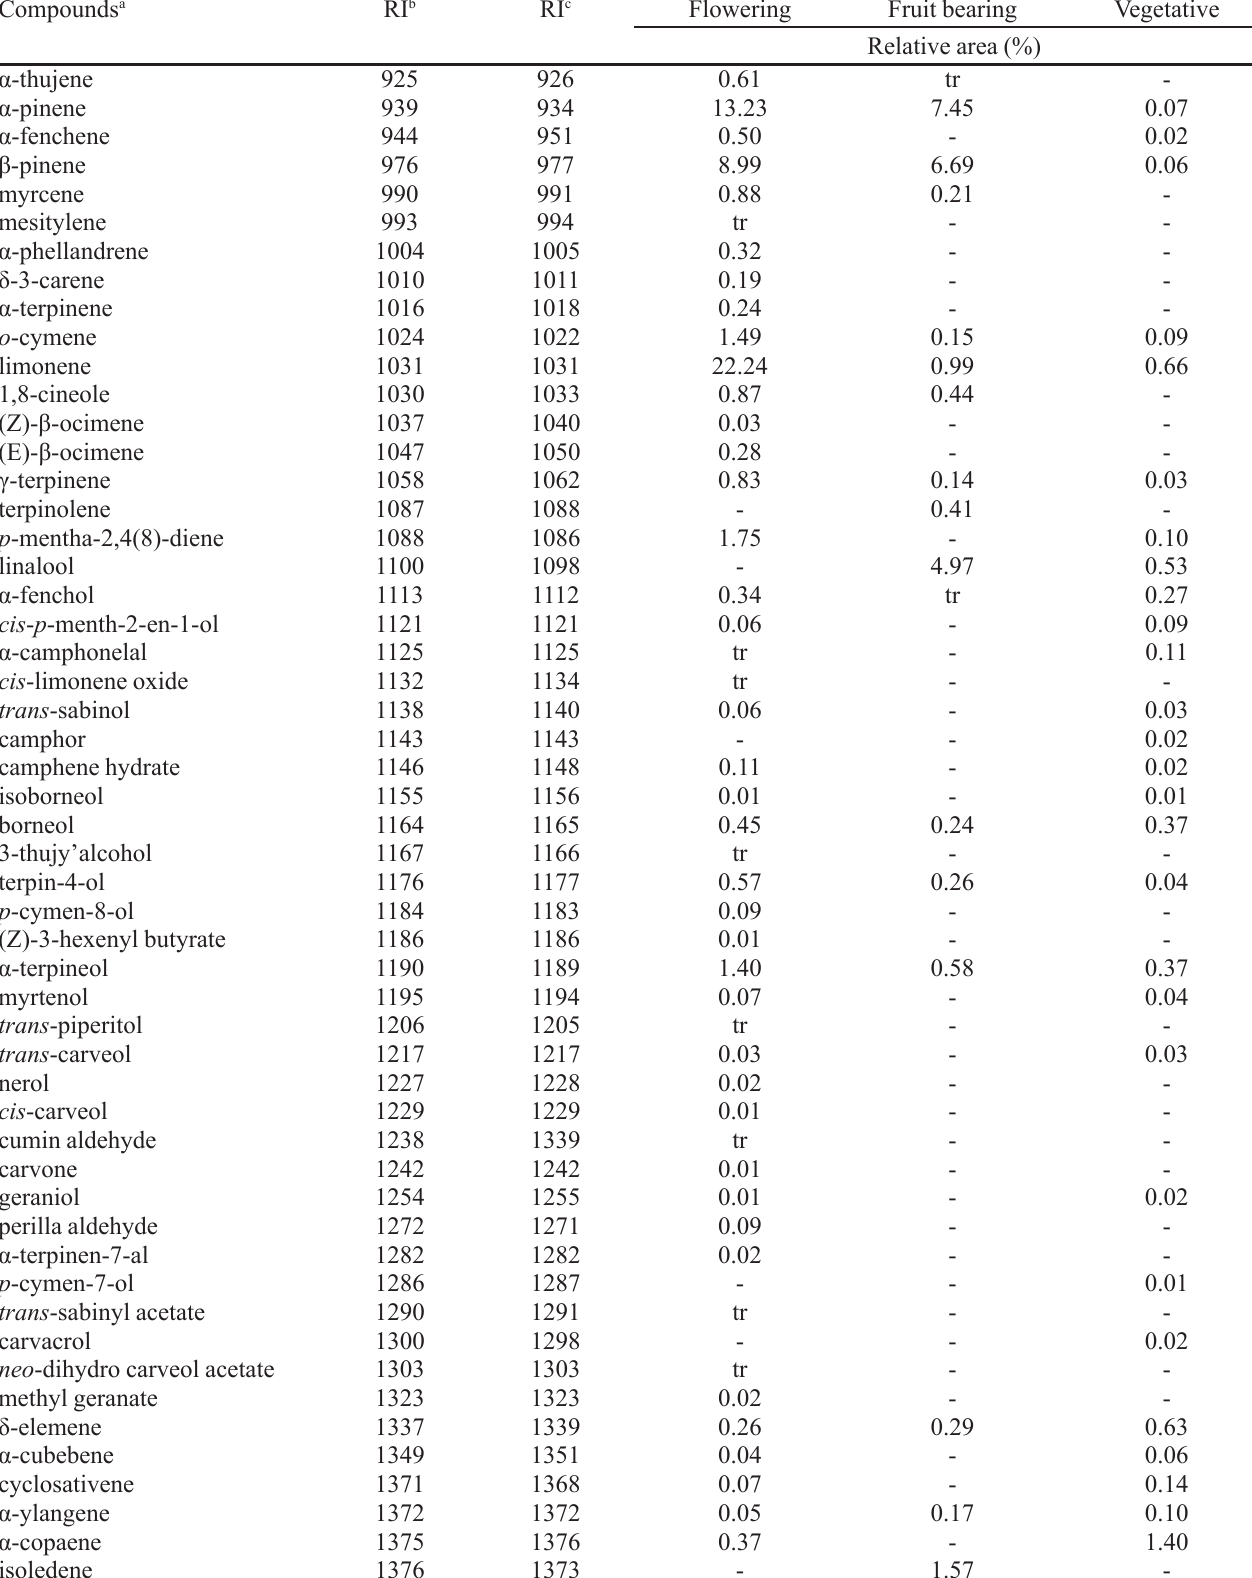
TABLE I - Volatile compounds identified in the essential oil of Campomanesia adamantium leaves at different phenological stages Compounds